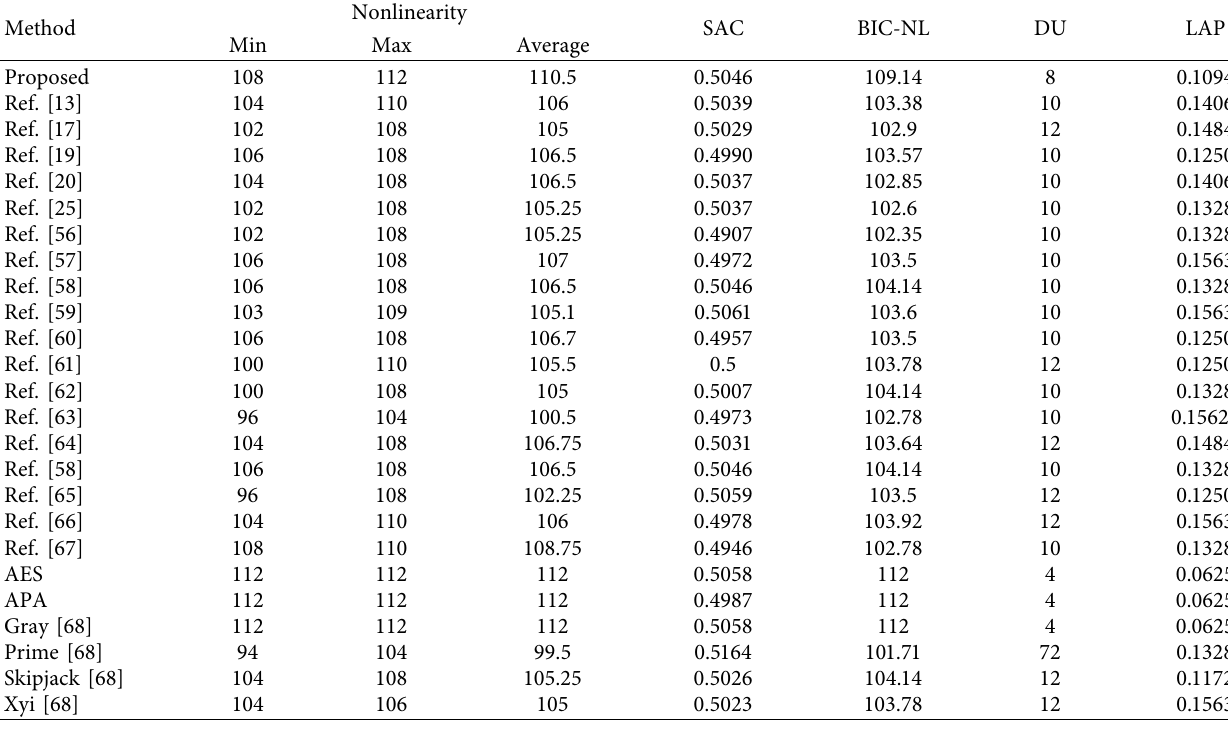
Table 7: Performance comparison of proposed S-box with recent S-box